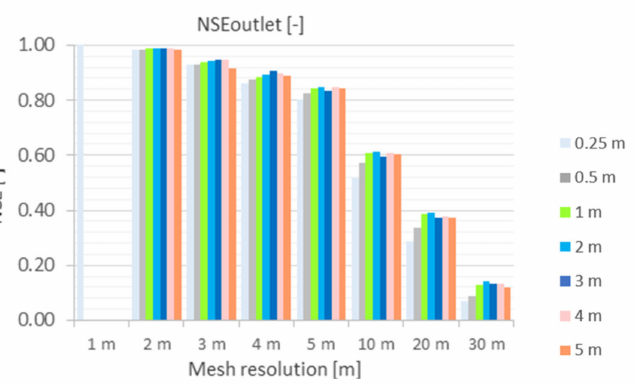
Figure 9. Overview of results of NSE (flow hydrograph) at the outlet of the catchment for the different mesh and DEM resolutions (DEM: colored legend).